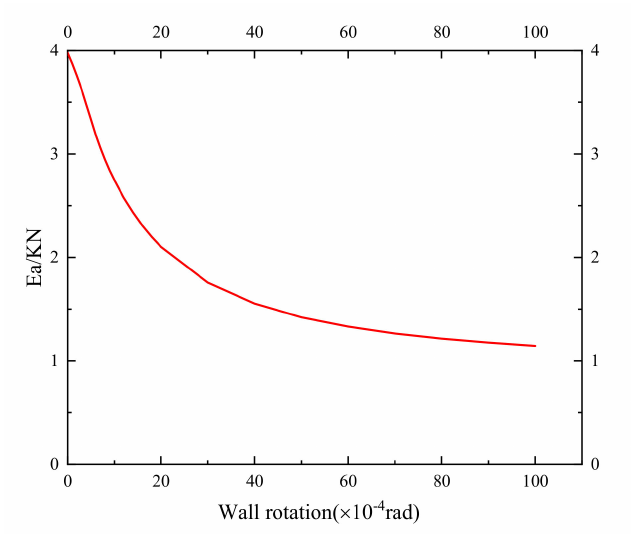
Figure 7. Combined earth pressure forces with varying rotation